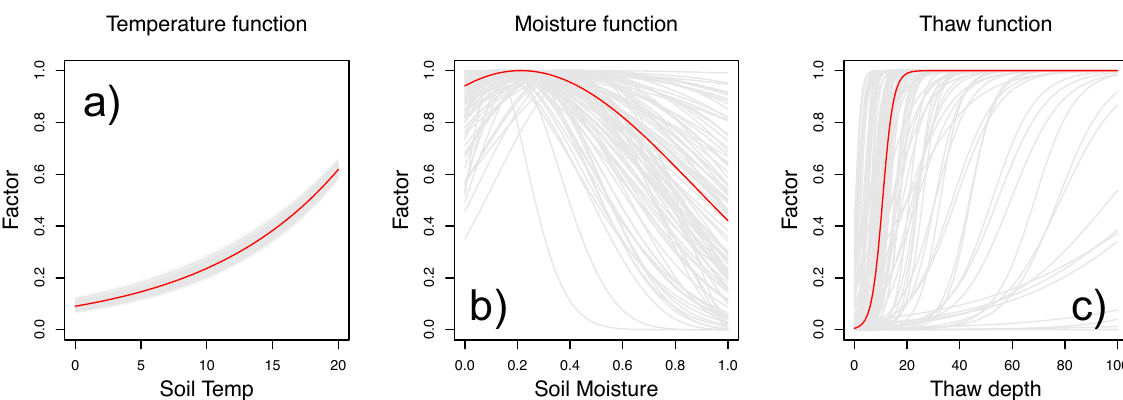
Figure 4. Limiting functions for (a) soil temperature, (b) soil moisture, and (c) thaw depth of CO 2 efflux simulated by posteriors ( n = 1000). Red solid lines are simulated from posterior median.